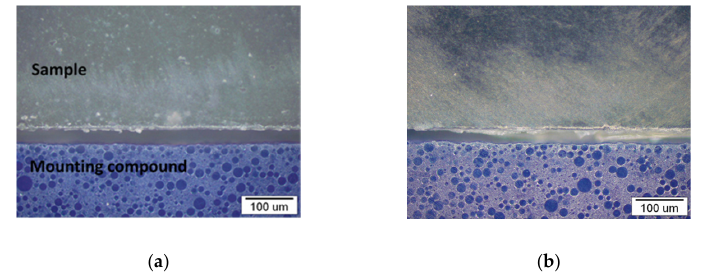
Figure 8. Micrographs of the boundary surfaces of the samples: PP ( a ), R-PP ( b ). As can be seen for the same injection pressure and temperature as PP/R-PP and all WF-PP/WF-R-PP specimens, the thickness of the boundary layers is mainly affected by the WF loading. Moreover, the thickness of the skin layer represented on Figure 9 varied from 18.5 µm for WF -PP-5 composites to 2.9 µm for WF -PP-40. There was not much difference in the thickness of the skin layer, about 7.8 µm, between the composites with WF loading from 10 to 20%. In fact, the recycled WF-R-PP composites showed the same trend of skin layer thickness, from 20 µm for WF-R-PP − 5 composites to 2.3 µm for WF-R- PP − 40 composites. Compared to PP/R-PP, the layer is thicker and varies from 28.3 to 34.7 µm. The reason for the decreasing effect of skin thickness is probably due to the orienta- tion of WF in the PP matrix, which are preferentially oriented in the core layer with PP matrix at low WF loading. Since this has been clearly studied in the case of PP-PET micro- fibril composites [45], we can predict the same conclusions there as well. When the content of WF in PP is low, the PP melt pushes WF into the mold, resulting in a preferential ori- entation of WF in the core. When the loading of WF in the PP matrix increases, the orien- tation of WF in the thin skin layer is also oriented. The results are in agreement with liter- ature data, and it was found that with increasing WF loading, the skin layer of the polymer (PP, R-PP) becomes degreased, and this is more pronounced at 30 and 40% added WF. The latter is in accordance with the ATR-FTIR results.